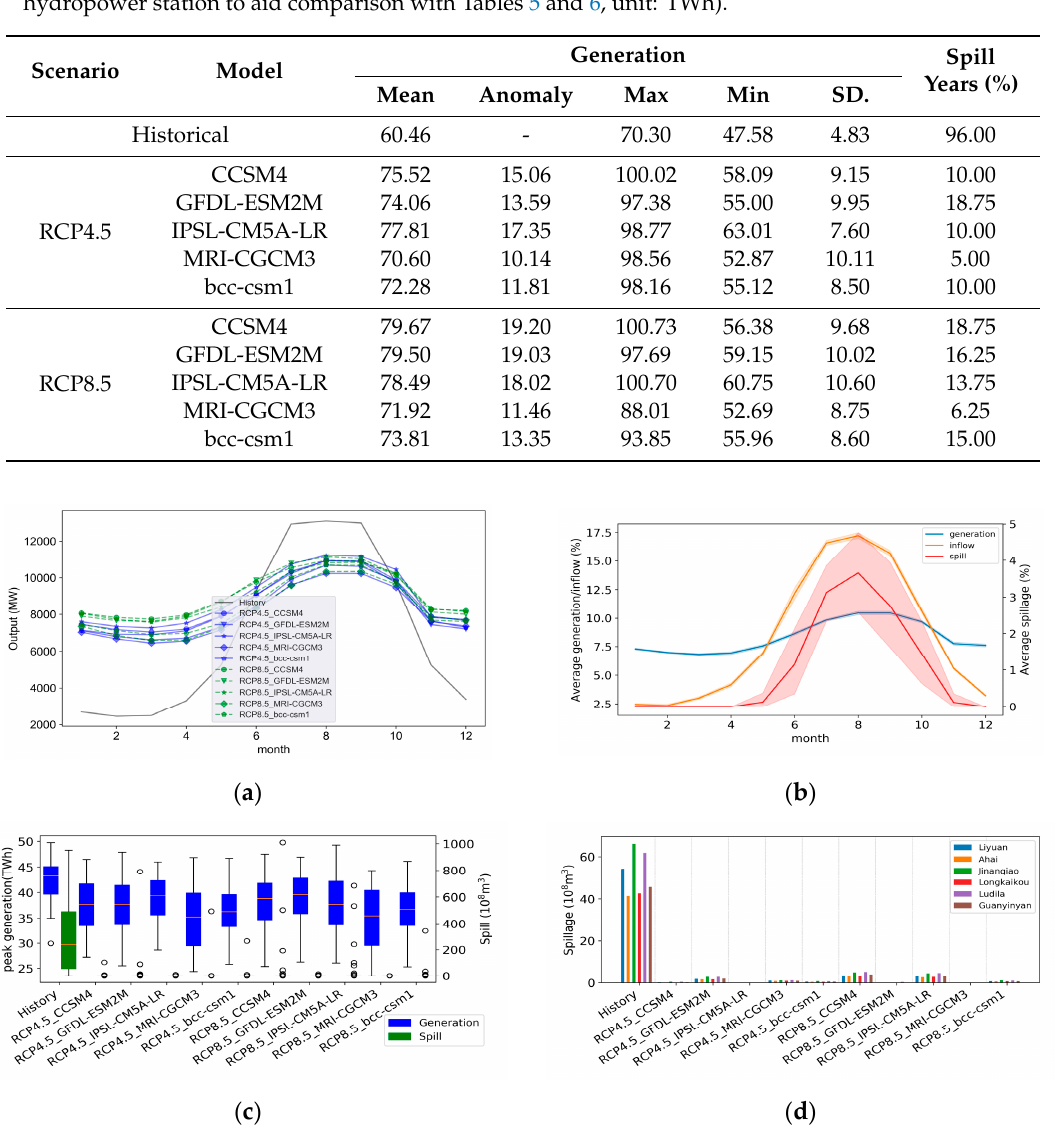
Figure 11. The generation and spill of JSCHS under different climate change projections with Longpan commissioned (does not contain the generation of Longpan hydropower station in order to compare the result). ( a ) Average monthly output, ( b ) average monthly percentage of inflow, generation and spillage, ( c ) peak generation and spill distribution, and ( d ) annual average spill of each station.